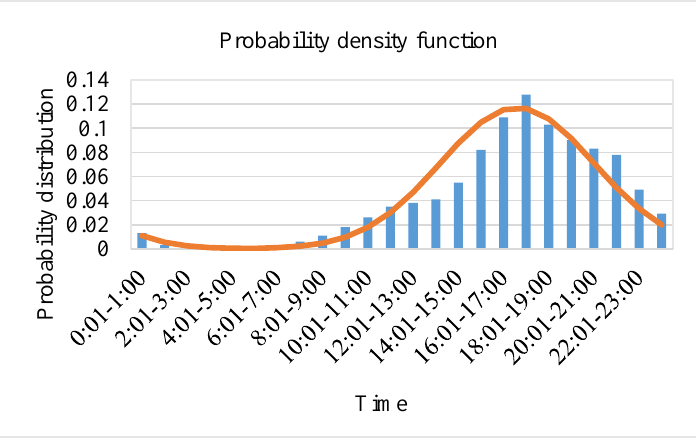
Figure 2. Probability density function of the ending time of the last trip.